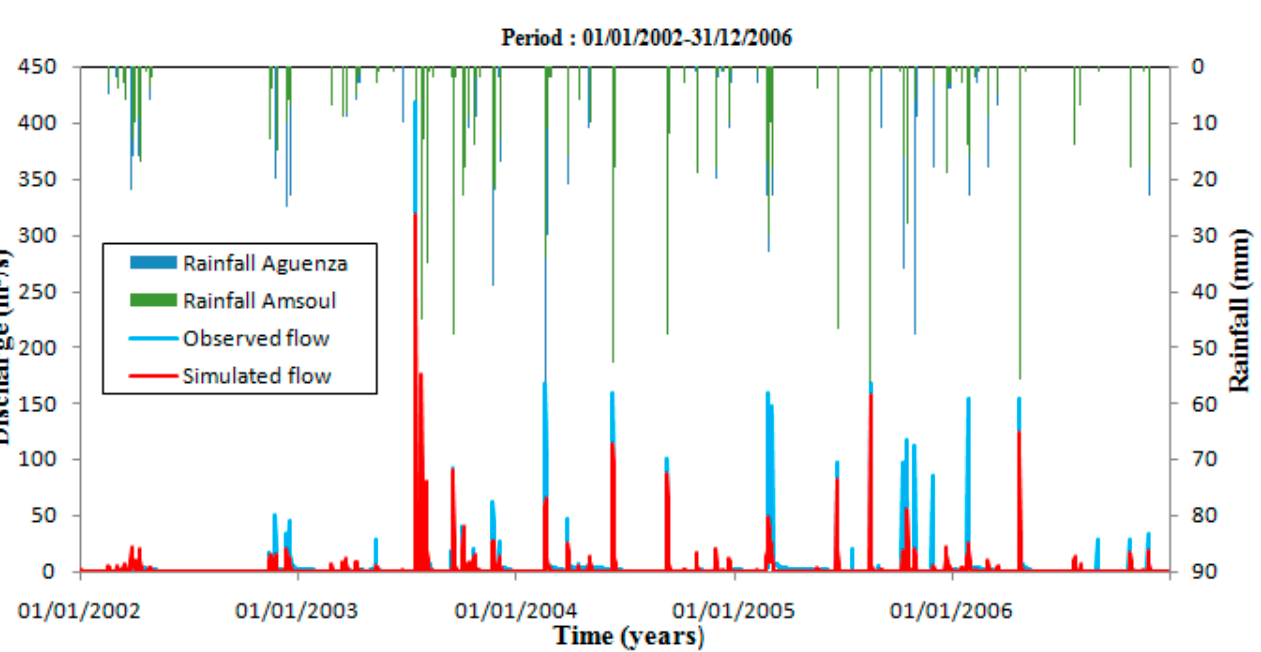
Figure 10. Graphical illustration of the ATHYS model output over the five years (2002–2006) used for calibration.